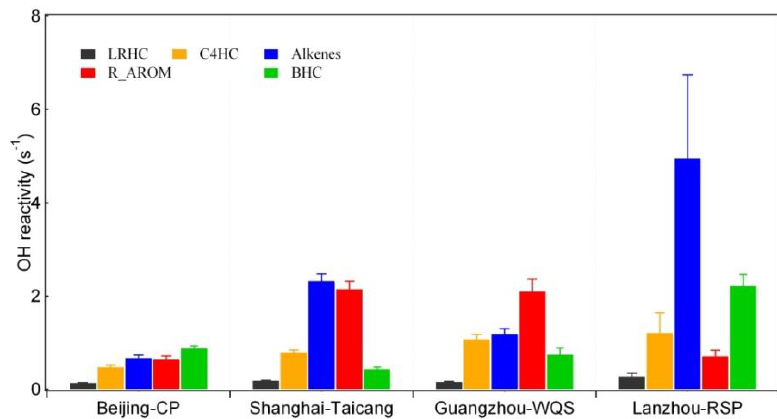
Figure 3. Average OH reactivities of major hydrocarbons at the four cities. The error bar is standard error.